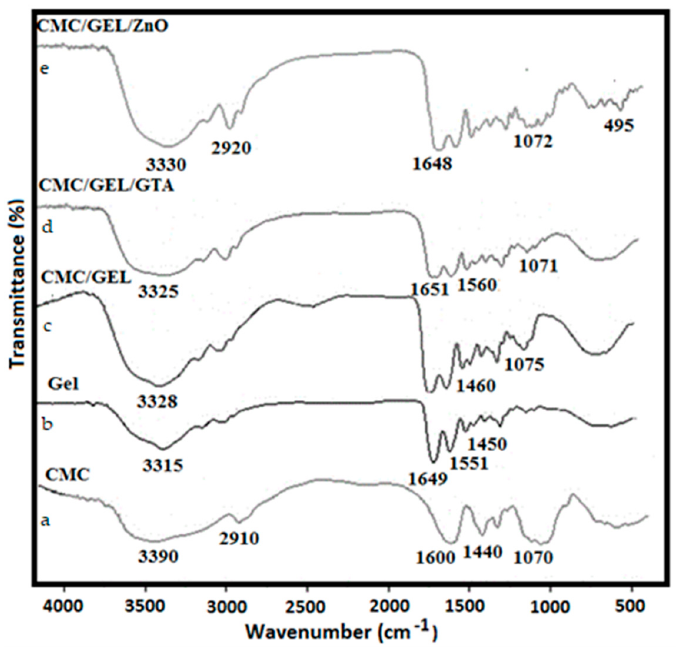
Figure 1. FT-IR Spectra of CMC/Gel/ZnO-Nps hydrogel films: ( a ) CMC, ( b ) Gel, ( c ) CMC/GEL, ( d ) CMC/GEL/GTA, ( e ) Table 1. Peak positions and vibration modes in CMC/GEL/ZnO nanocomposites hydrogels. Wavenumber (cm − 1 )